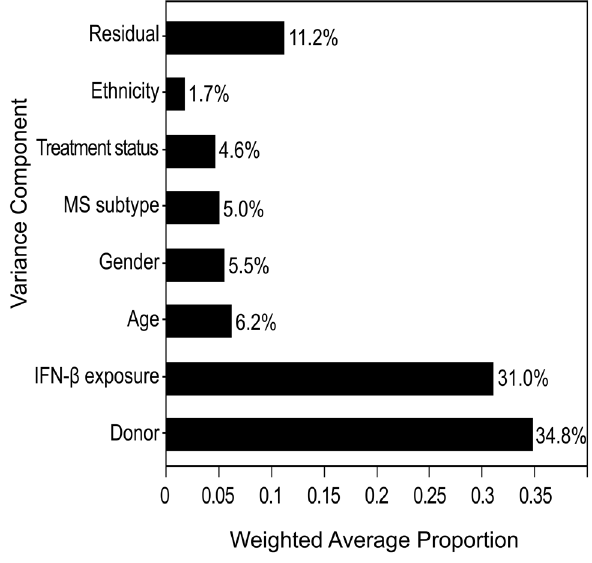
Figure 2. Proportion of variance in gene expression is explained by a major IFN- b response component and donor- specific components. Variance component analysis was modeled with the following components: Donor - representing variance contributed by unspecified differences between donors; IFN- b exposure ( in vitro IFN- b treated LCL sample versus the untreated sample); Age (stratified to under 40 years old or above); Gender; MS subtype (relapsing remitting, relapsing progressive, secondary progressive), Treatment status (IFN- b treatment naı¨ve donors, or donors treated for at least 1 year at the time of sample collection); and Ethnicity (Jewish/ Arab). The Residual component models all the variability that cannot be attributed to any of the explicit variance